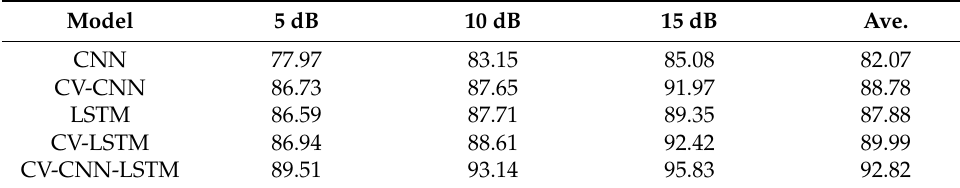
Table 2. The STOI (in %) scores of different models at different